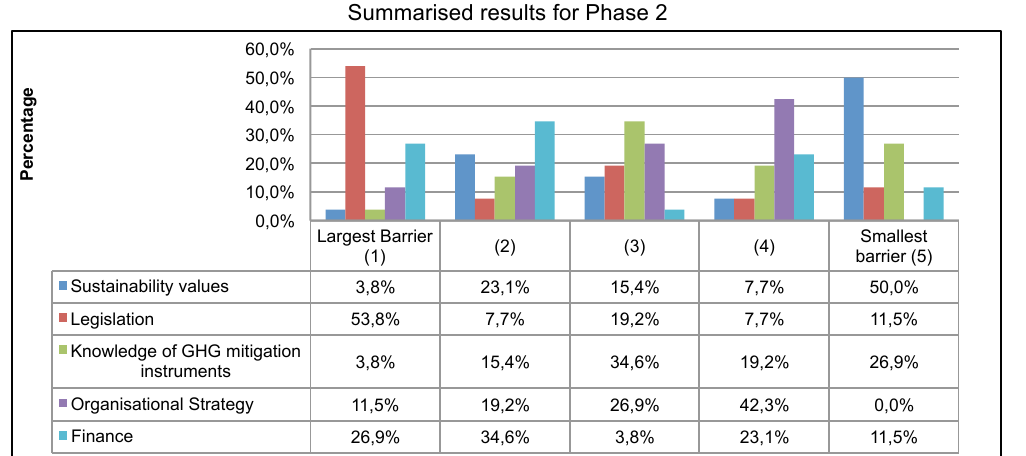
Summarised results for Phase